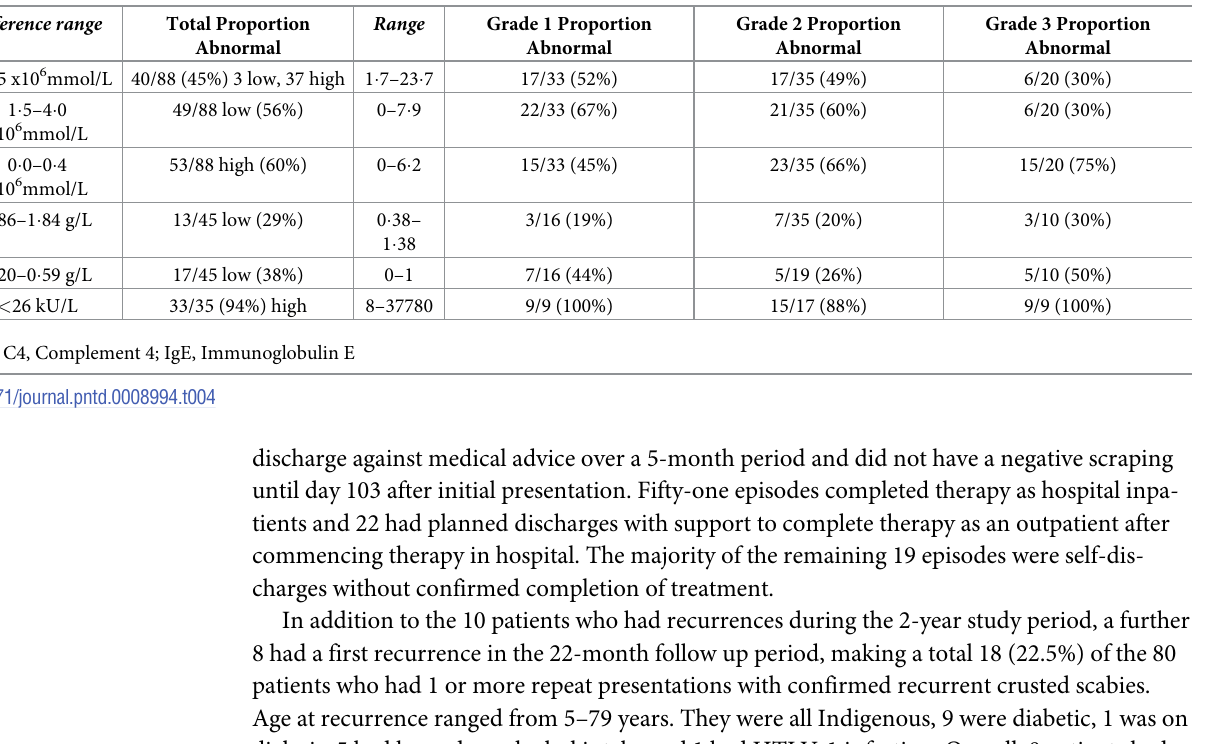
Table 4. Number of episodes with laboratory values outside the reference range.